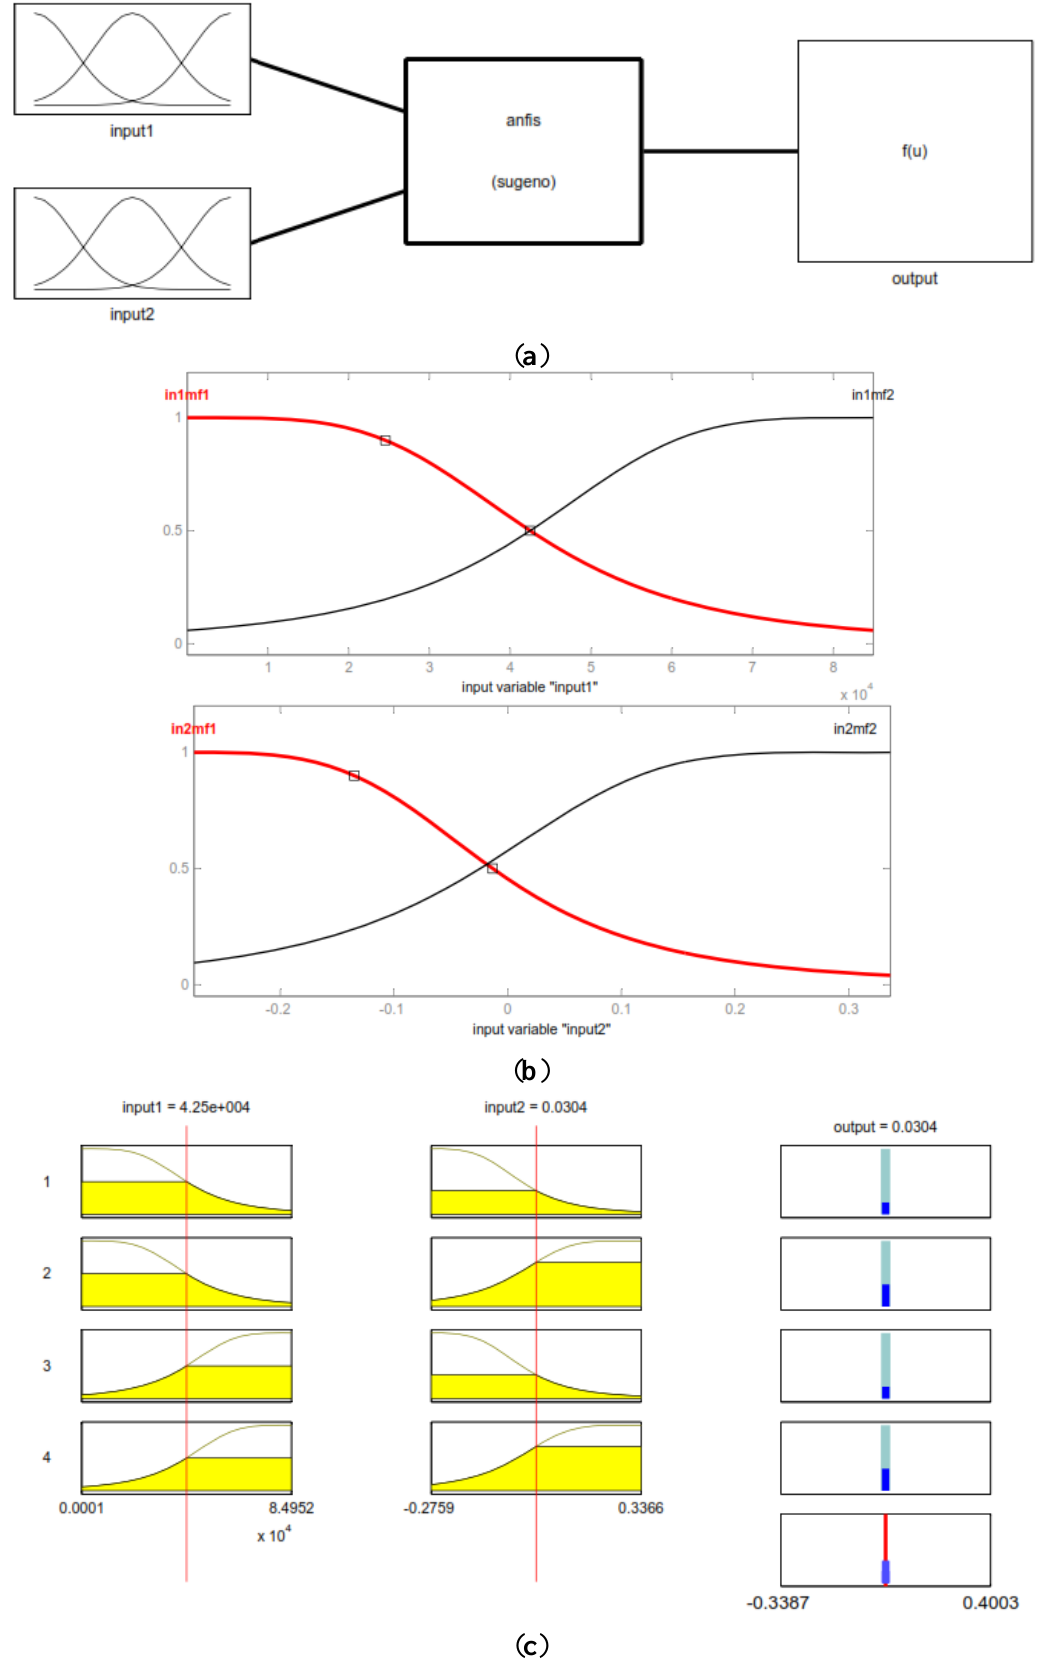
Figure 8. The ( a ) design model, ( b ) MF adjustment and ( c ) model application of two MF and two inputs time series ANFIS prediction